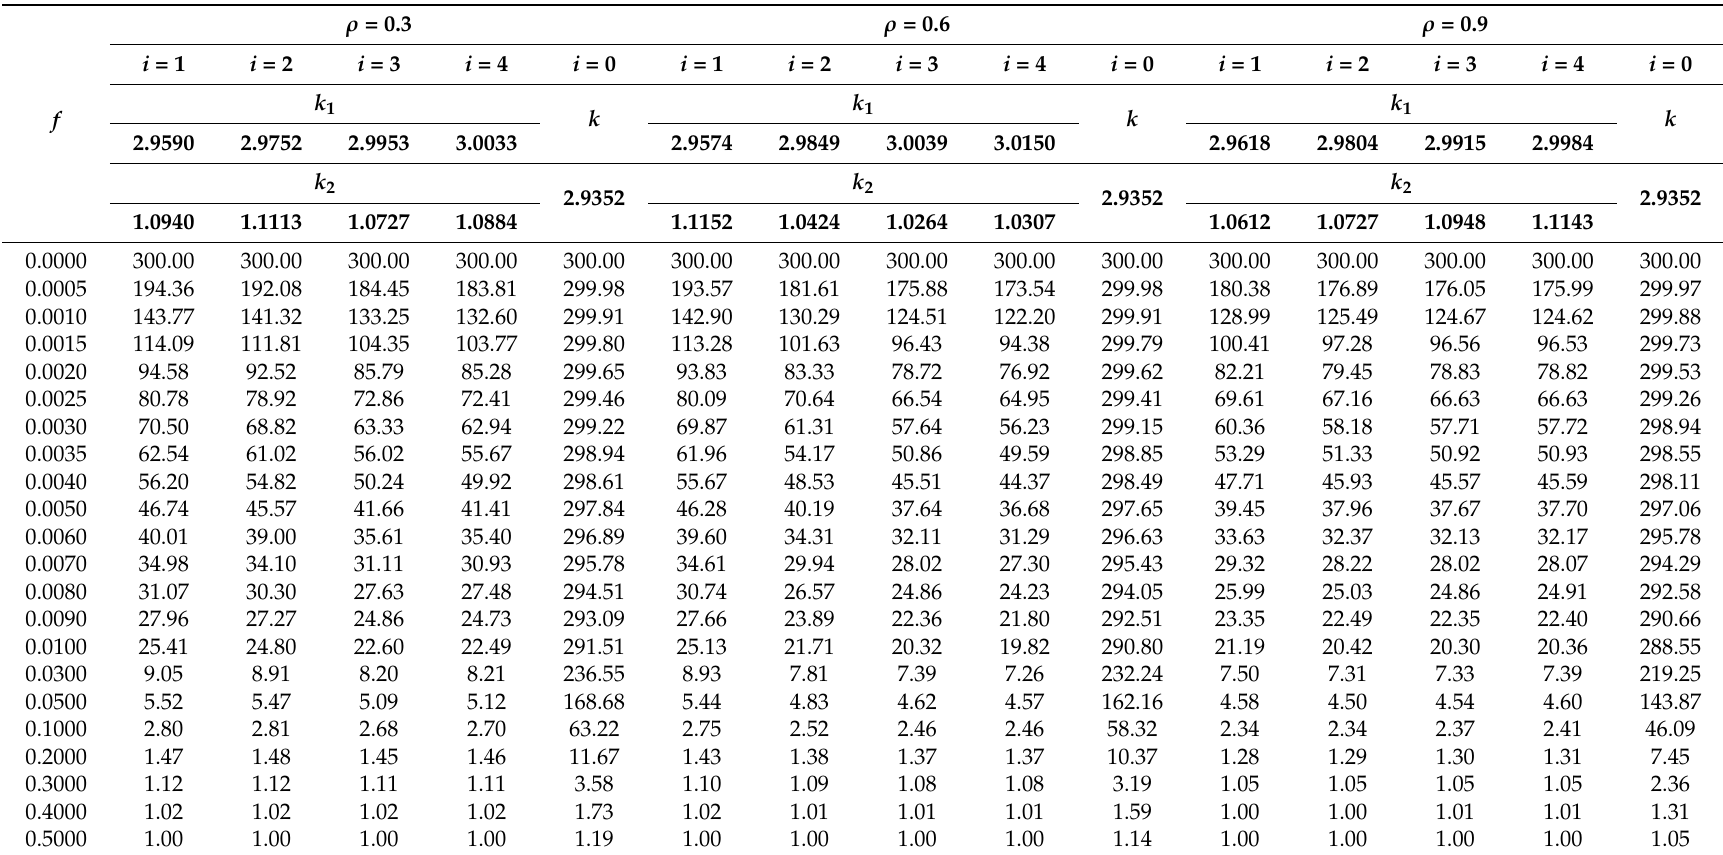
Table 3. The ARL analysis for 300 with n =